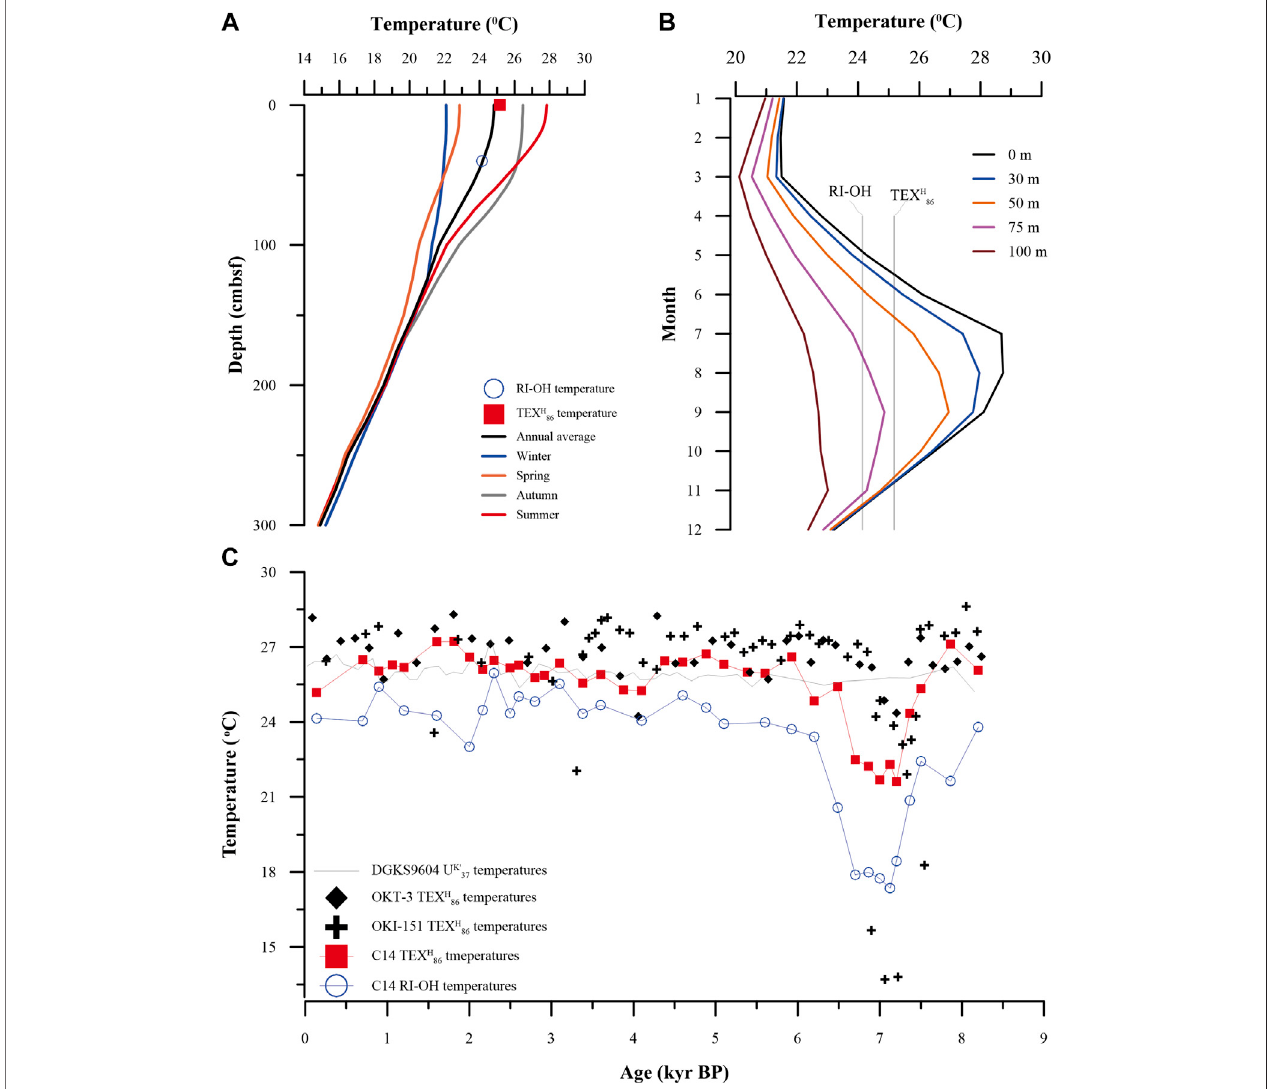
FIGURE 3 | Paleotemperatures derived from core C14 and nearby sites. (A) Mean seasonal and annual temperatures at the study site; (B) monthly mean water temperatures at different depths at the study site. Data are from Locarnini et al. (2013). (C) Comparisons between BIT, TEX H 86 and RI-OH temperatures from core C14 fromthemiddleOT,TEX H 86 temperaturesfromOKT-3andOKI-151fromthesouthernOT(Zhaoetal.,2015;Xuetal.,2018),andU K ’ 37 temperaturesfromDGKS9604from the middle OT (Yu et al.,